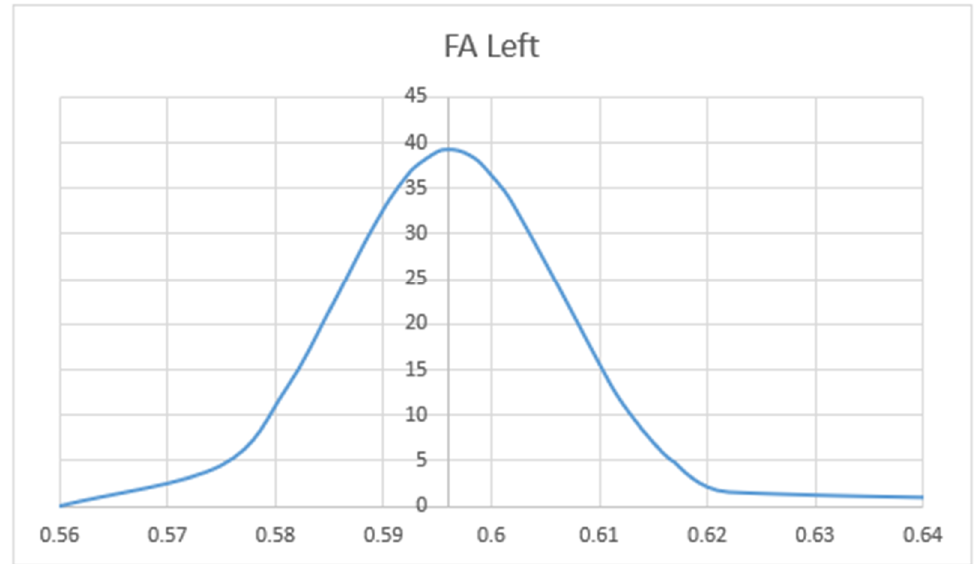
Figure 7. Distribution charts of fractional anisotropy (FA) in the left hemisphere of the group of 34 patients aged 25–82.